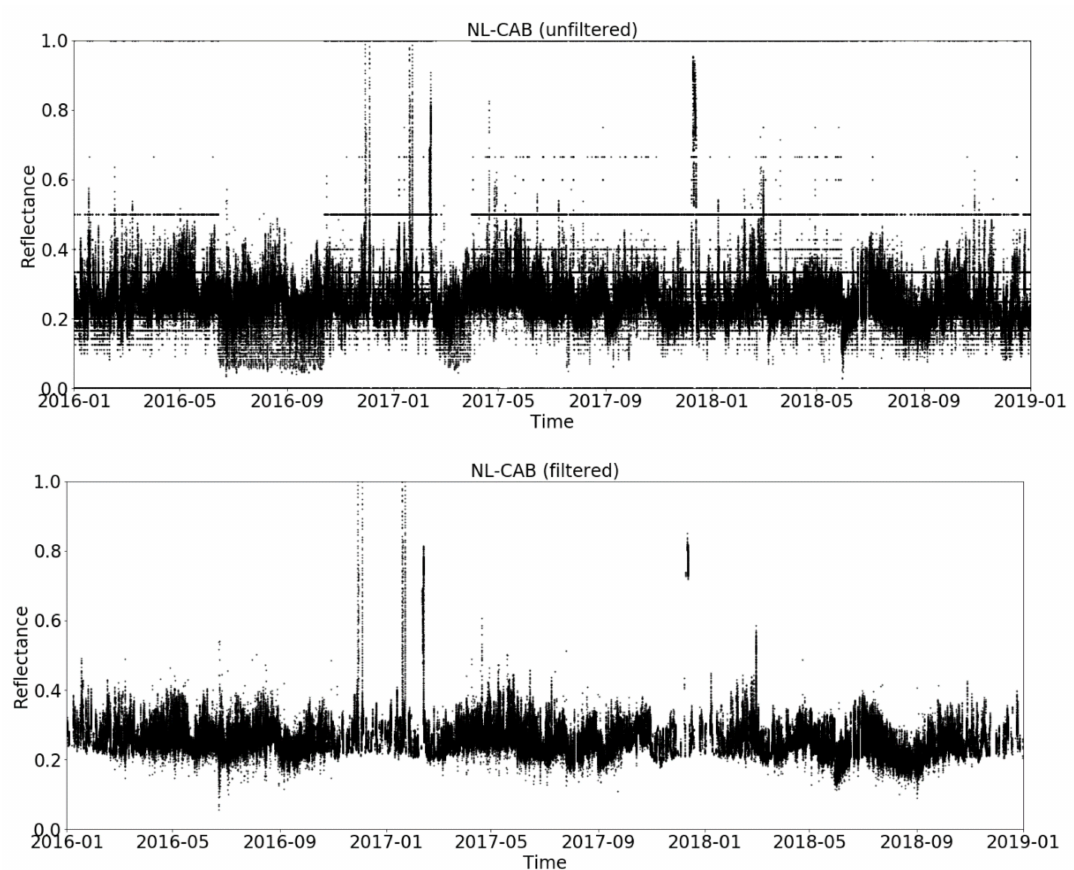
Figure 5. Comparison of unfiltered and filtered reflectance variations at the NL-CAB sites between the years 2016 and